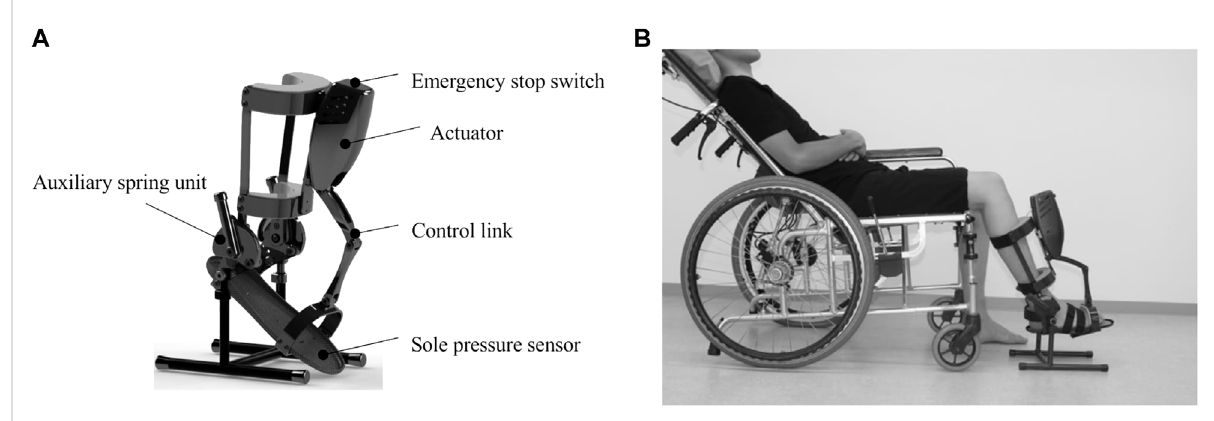
FIGURE 1 The main body of the developed device and the standard position for